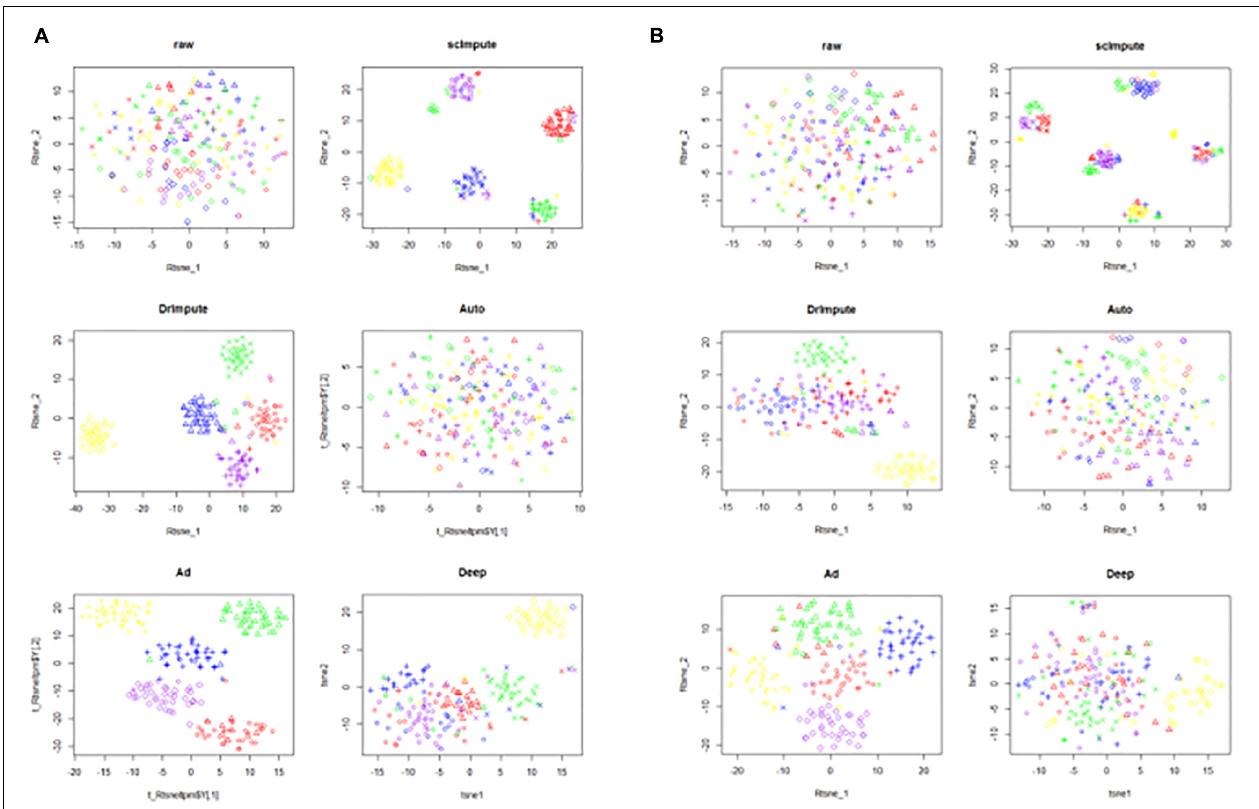
FIGURE 5 | The visualization results of clustering on the simulated data sets. The six images are the clustering results of the raw data and the clustering results imputed by scImpute, DrImpute, AutoImpute, AdImpute, and DeepImpute. And (A) is the clustering visualization results on simu1 data set; (B) is the clustering visualization results on simu2 data